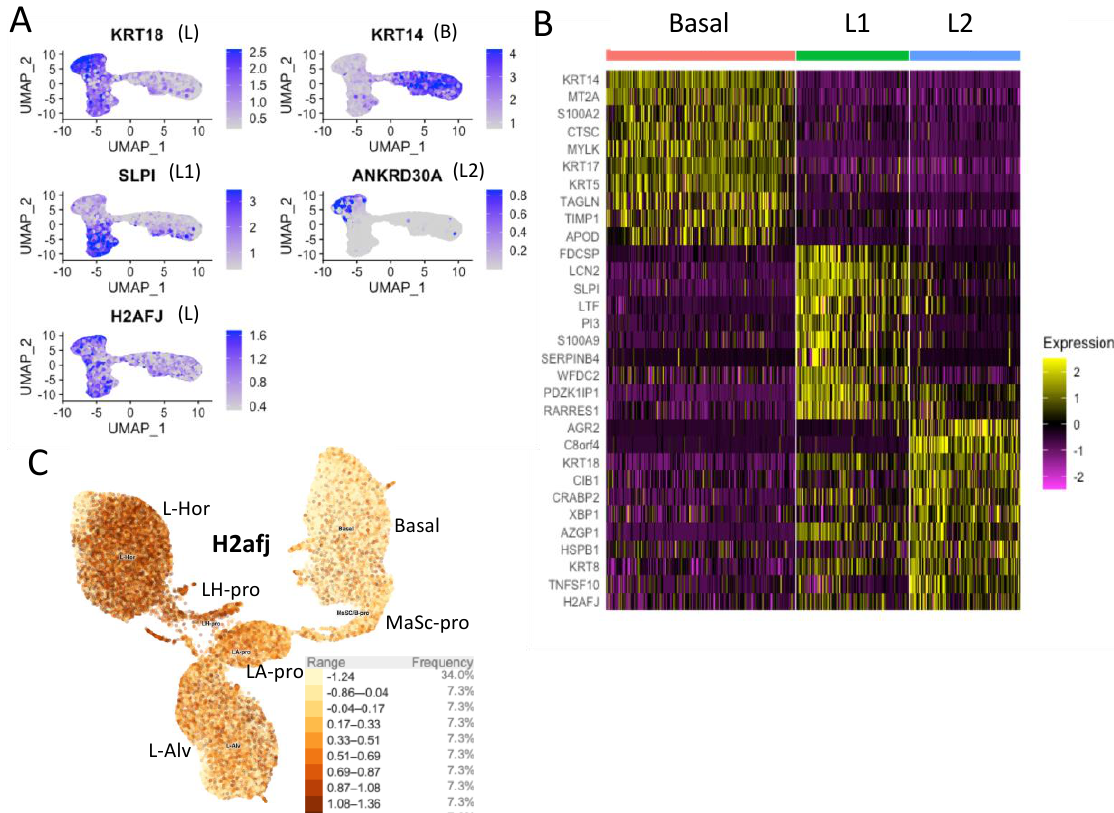
Figure 3. Single-cell RNA expression of human and mouse mammary epithelial cells. ( A ) UMAP representation of RNA expression for the indicated genes in single human mammary gland cells. This UMAP analysis identified 2 luminal-cell clusters (L1, L2) and a basal-cell cluster ( B ). The H2AFJ and KRT18 RNAs are found in both luminal-cell clusters. ( B ) Heat map showing the top 10 genes specific for each human mammary cell cluster along with the H2AFJ gene in the last row. ( C ) H2afj gene expression in a UMAP clustering of single cells from the mouse mammary gland. This UMAP analysis revealed 6 cell clusters: Luminal-Hormone-sensitive (L-Hor), Luminal-Hormone-sensitive progenitor (LH-pro), Luminal- Alveolar (L-Alv), Luminal-Alveolar progenitor (LA-pro), Basal, and Mammary Stem/progenitor Cell (MaSc-pro). H2afj RNA is enriched in the luminal cell clusters with the highest levels in the Luminal-Hormone-sensitive cluster. We further examined H2AFJ expression in 28,606 single normal prostate cells from 3 men aged 18–31 years old [25]. As for the mammary glands, H2AFJ RNA